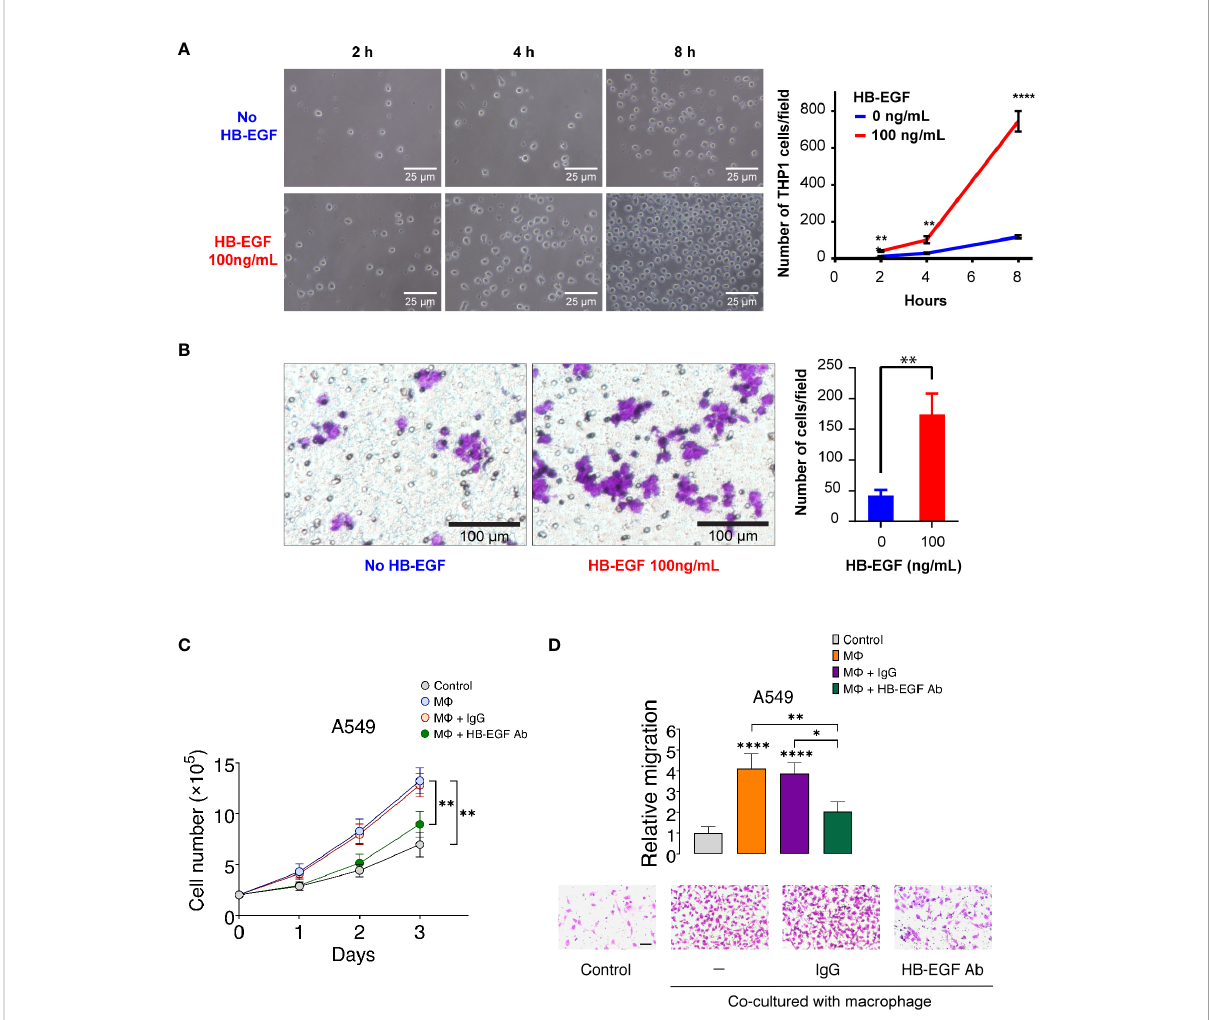
FIGURE 5 HB-EGF promotes monocyte and macrophage migration: (A) The short-term effect of HB-EGF mediated monocyte migration. A total of 5 × 10 5 THP-1 cells were used in a transwell migration assay. HB-EGF was added to the lower well at a concentration of 100 ng/mL. The migration cells were observed at 2, 4, and 8 h. The right panels present representative images (magni fi cation, 200×), the left panel shows the quanti fi cation of migrated cells, and the bar presents the mean and SD. (B) HB-EGF mediated macrophage migration. A total of 10 5 THP-1 cells were differentiated into macrophages in PMA (10 ng/mL) for 48 h in the insert well of a 24-well Transwell plate prior to Transwell migration with 100 ng/mL HB-EGF for 8 h. The left panel shows representative images (magni fi cation, 200×); the right panel presents the quanti fi cation of migrated cells, and the bar shows the standard deviation. Wilcoxon rank-sum tests were used to compare the number of migrated cells in two groups at each time point. **p < 0.01, ****p < 0.0001. (C) Effects of U-937-derived HB-EGF mediated the proliferation of A549 cells. U-937-derived M2 macrophages (M f ) were pretreated with anti-HB-EGF antibodies or control IgG for 24 h and then cocultured with A549 cells. The number of cancer cells was tracked for 1 – 3 days. Cell proliferation of A549 cells cocultured with M f was assessed after treatment with an